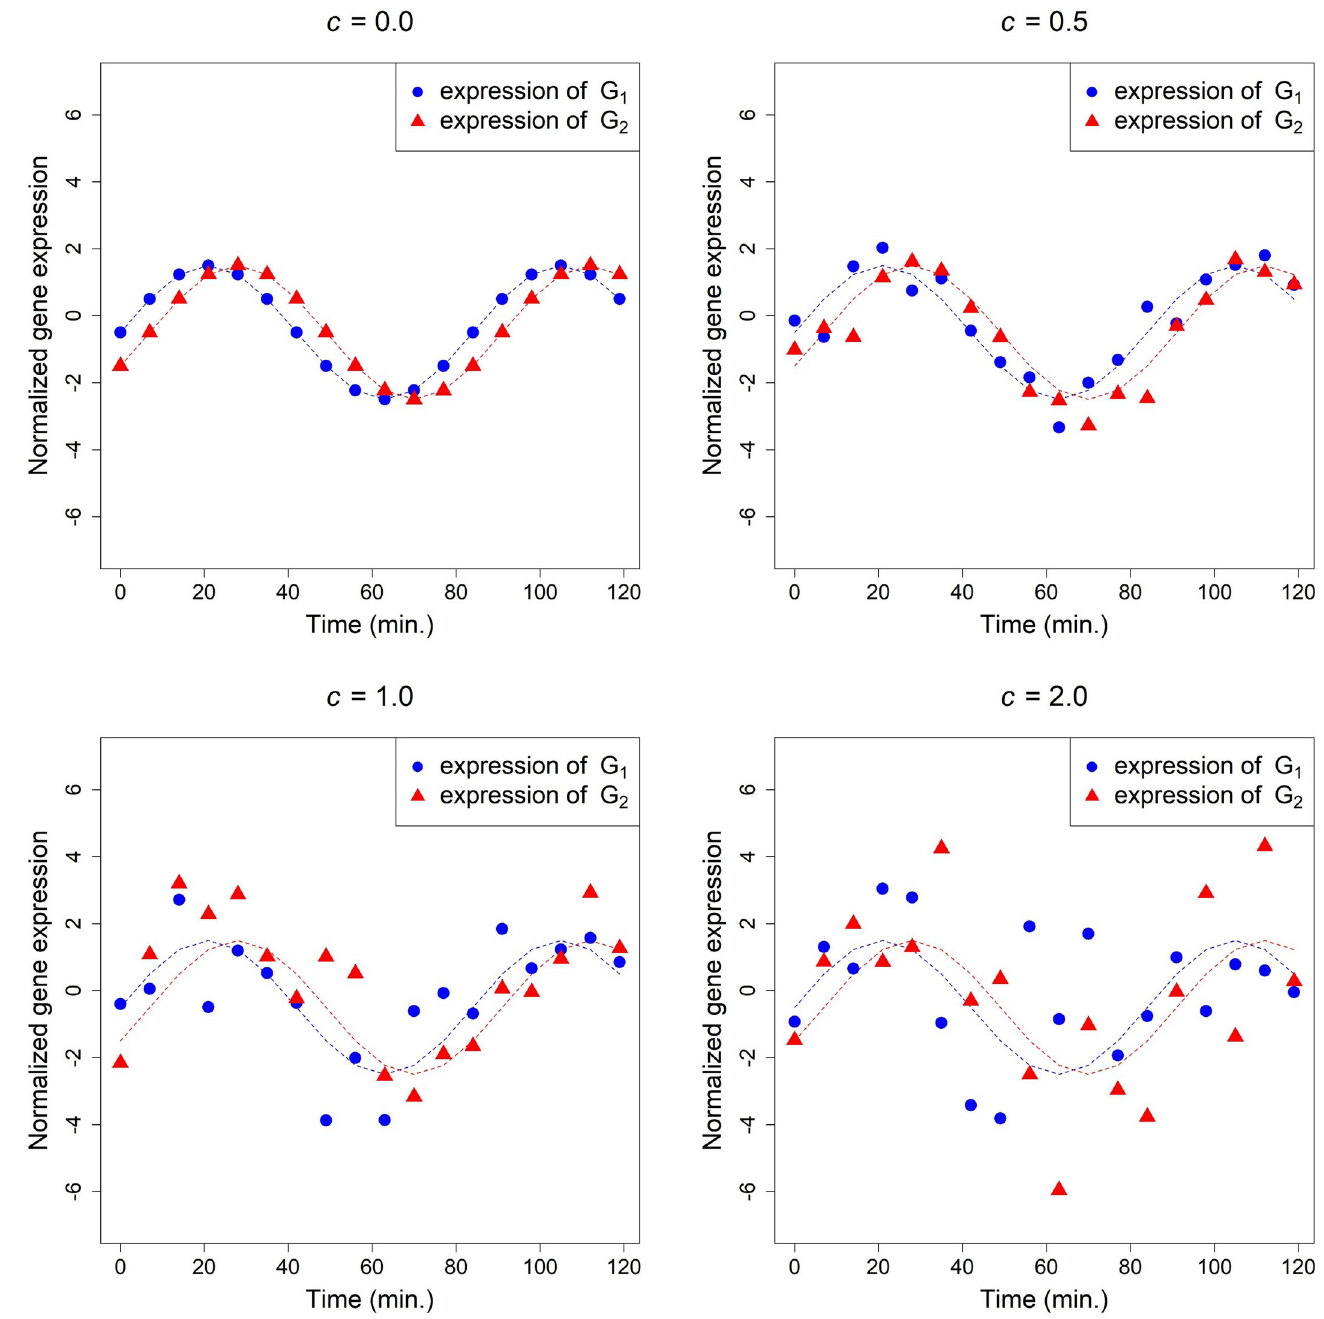
Fig 2. The simulated expression of gene G ... , 17.